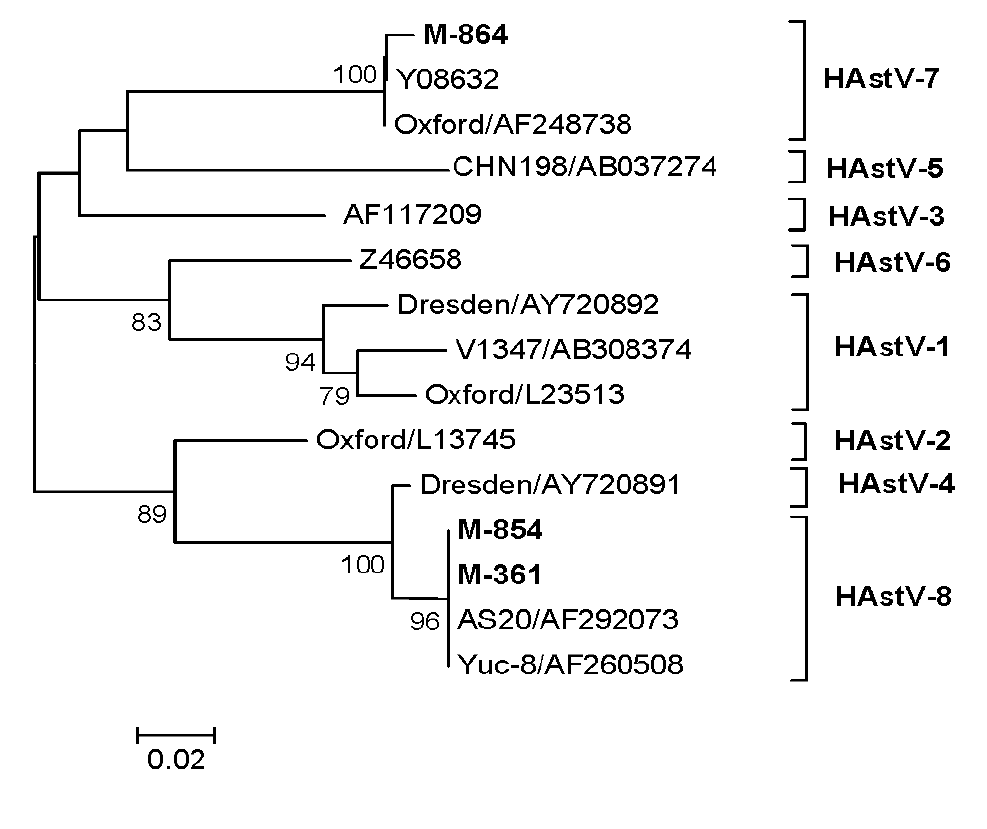
Figure 6. Phylogenetic tree based on the partial nucleotide sequences of ORF2 (190 bp) of HAstV strains. The strains of the present study are in bold face. Scale indicates genetic